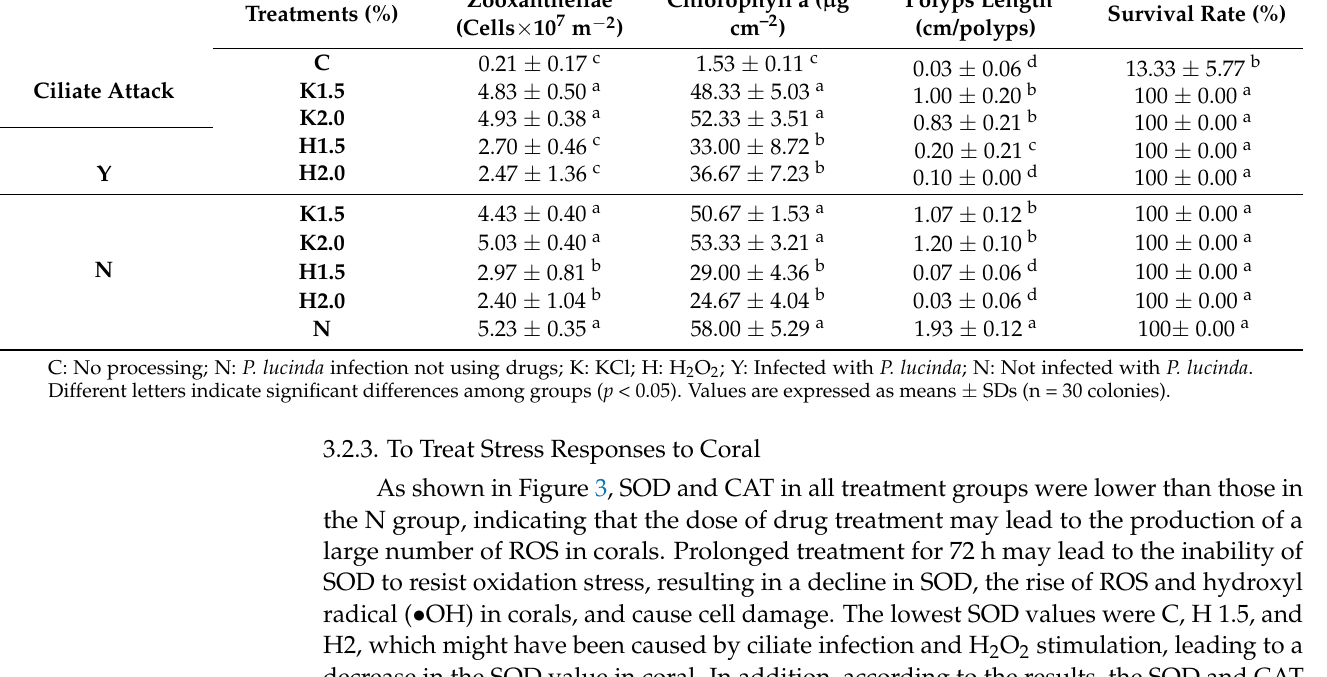
Table 3. Effects of KCl and H 2 O 2 on zooxanthellae, chlorophyll a, and the survival rate of corals. Treatments (%)